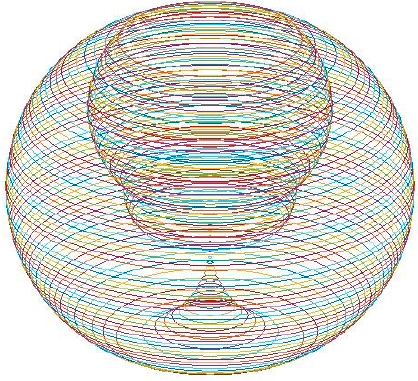
Figure 11. 3D workspace composed of boundary curves (281 layers).